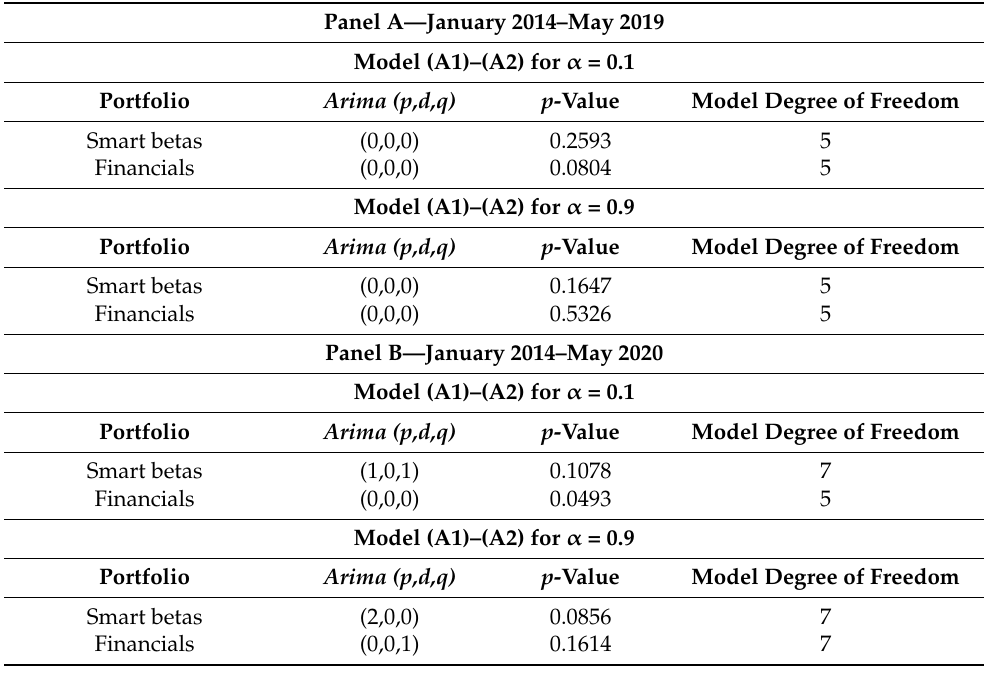
Table A6. Details on the results of auto.arima() corresponding to model (A1)–(A2) in Table